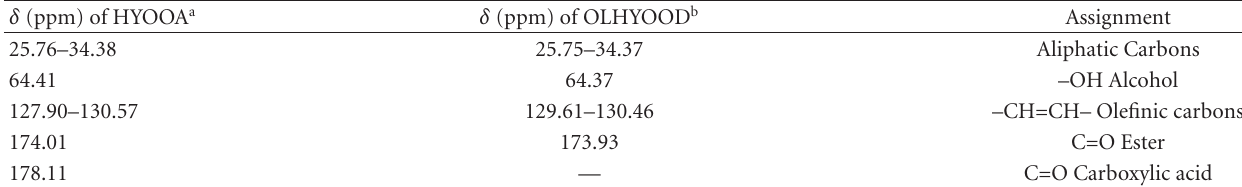
Table 6: The main signals present in 13 C NMR functional groups of HYOOA and OLHYOOD.